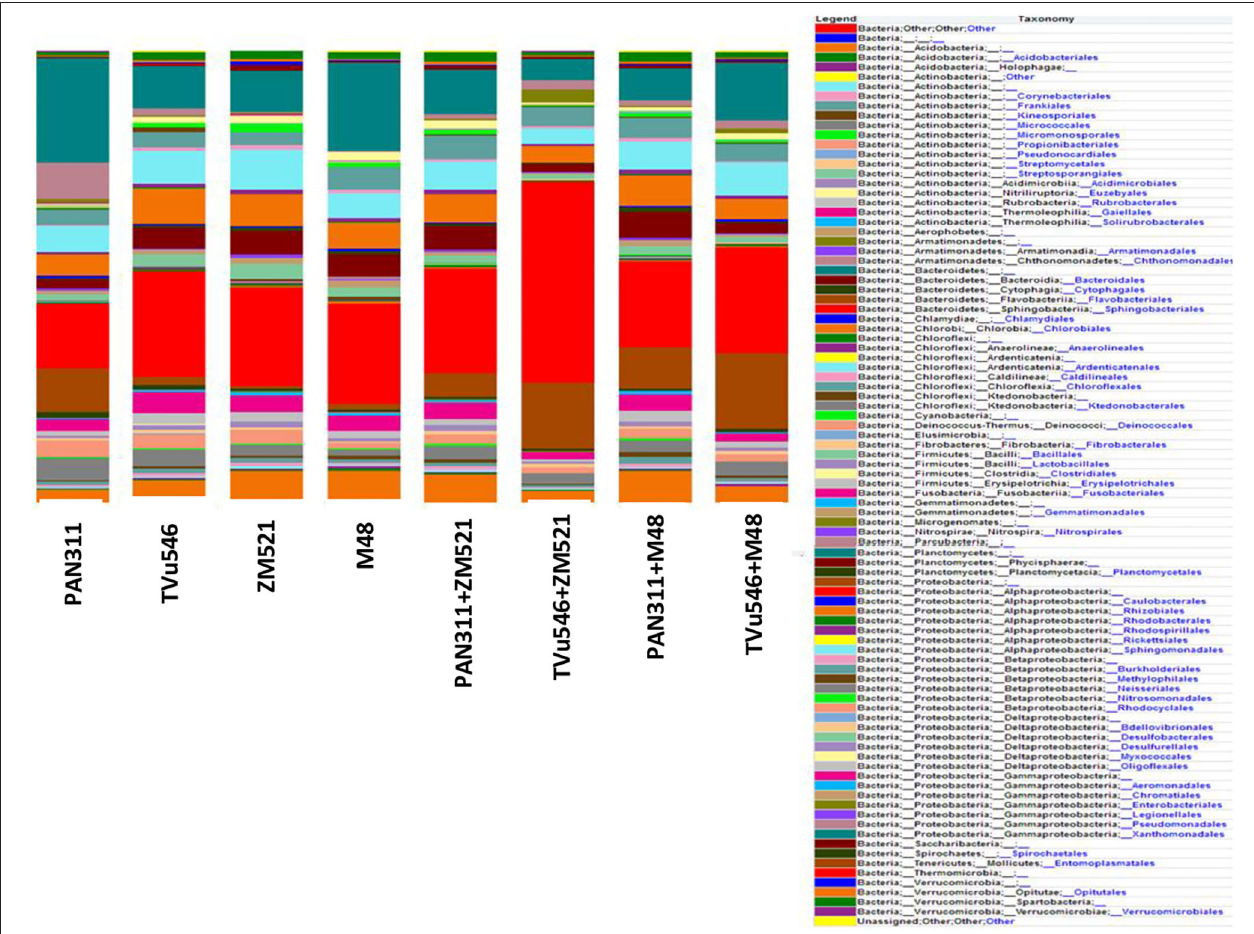
FIGURE 6 | Average distribution of 16S rRNA sequences classified at order level in rhizosphere of solo and intra-hole planted cowpea, sorghum, and maize. UniFrac metric. The PCoA of the UniFrac metric